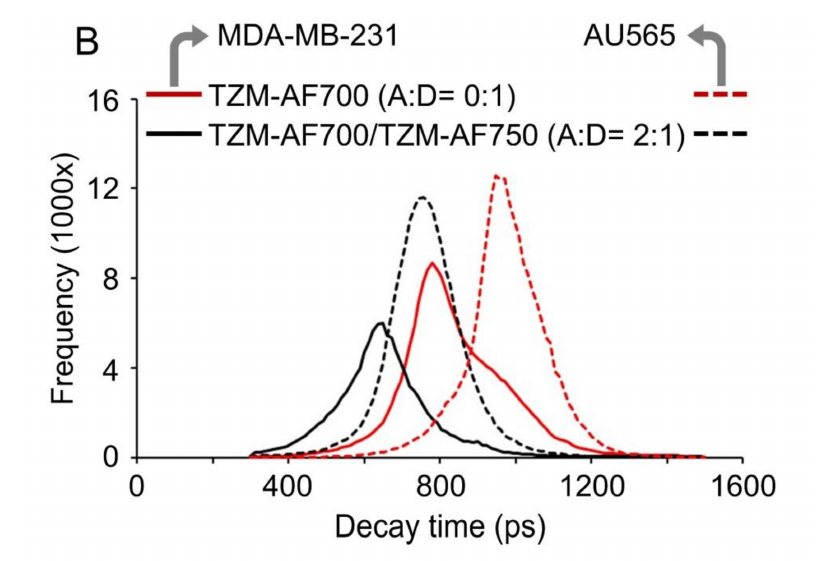
Figure 4. TZM FLIM-FRET analysis in MDA-MB-231 cancer cells. ( A ) The representative TCSPC images of fluorescence intensity and mean lifetime map ( τ m) in cells treated with TZM–AF700 (A:D = 0:1) or with TZM–AF700 plus TZM–AF750 (A:D = 2:1) pseudo-color range = 300–1500 ps. Scale bar = 50 µ m. ( B ) Comparison of fluorescent lifetime distribution in MDA-MB-231 (solid lines) and AU565 cells (dashed lines) treated with TZM–AF700 (A:D = 0:1 red), TZM–AF700 plus TZM–AF750 (A:D = 2:1